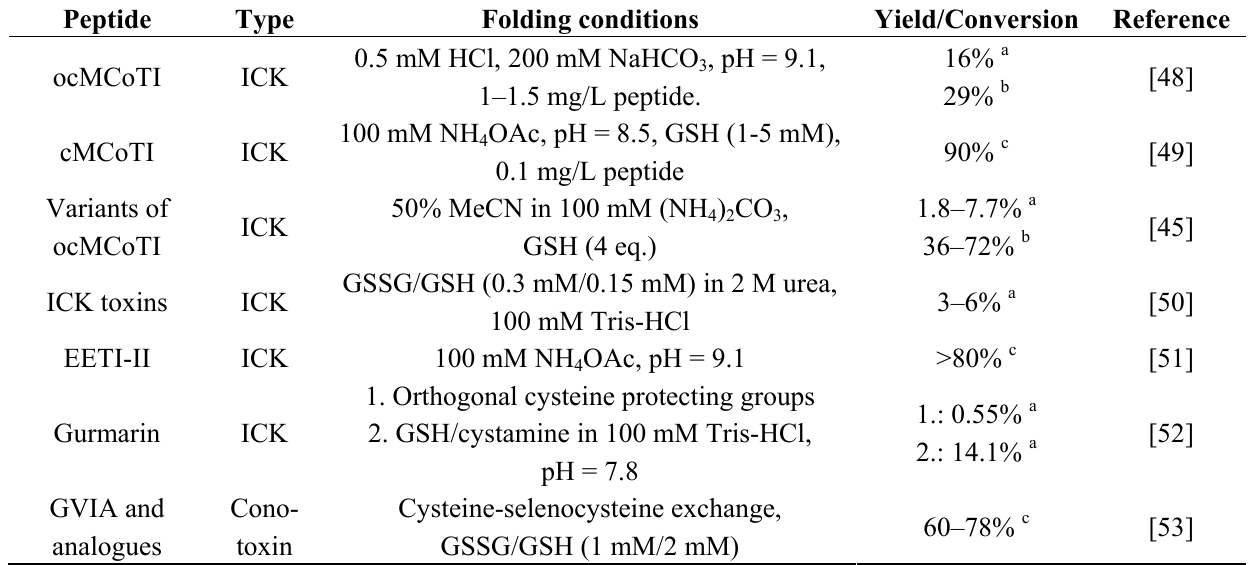
Table 1. Selected folding mixtures for a number of cystine-knot peptides from various